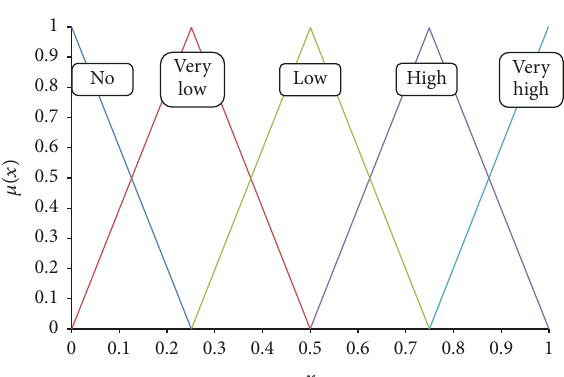
Figure 2: Membership functions for linguistic values in Fuzzy- DEMATEL